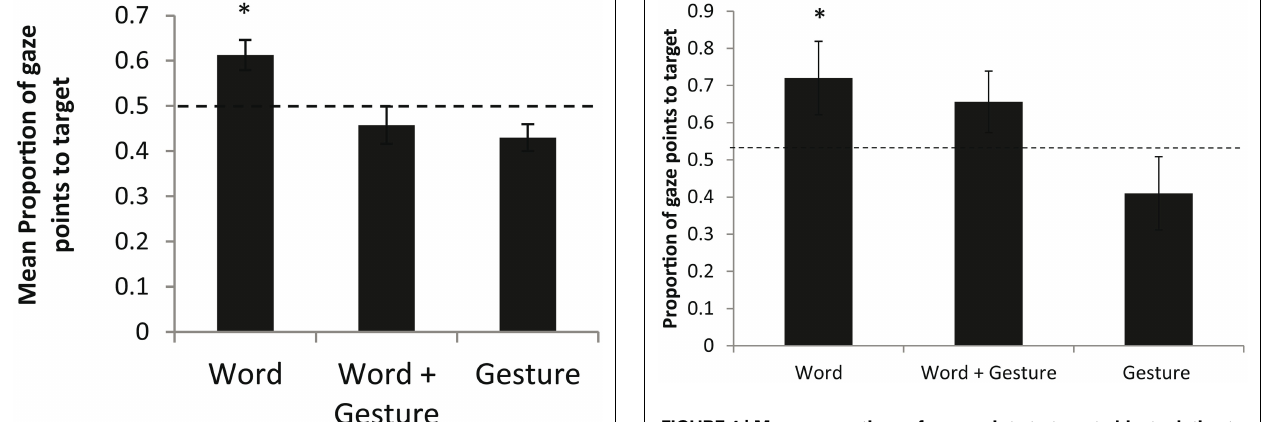
tests (two-tailed) using Least Significant Difference comparisons